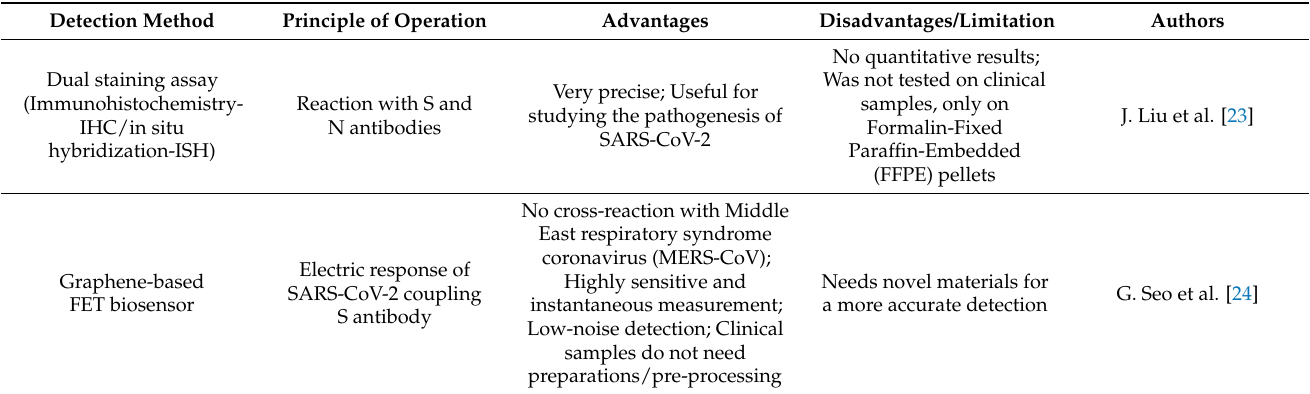
Table 1. Methods reported in the literature for COVID-19 detection through biological